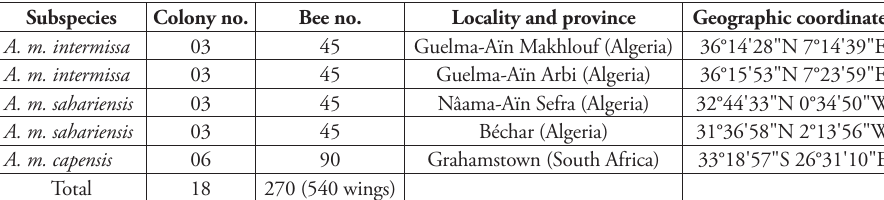
Table 1. Origin and sample size for Apis mellifera